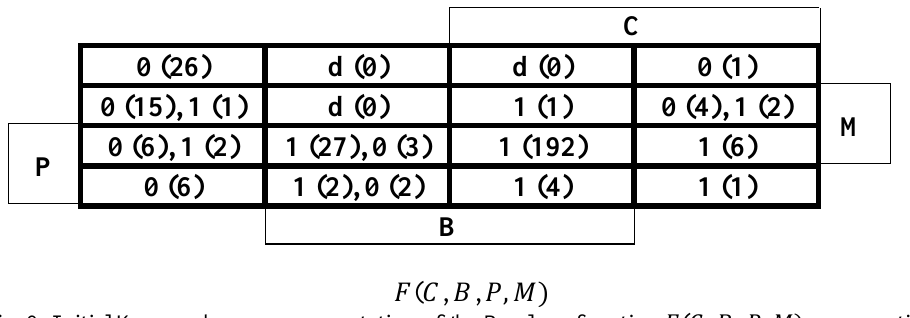
Fig. 9. Initial Karnaugh-map representation of the Boolean function 𝐹 ( 𝐶 , 𝐵 , 𝑃, 𝑀) representing an approximate gold standard with supporting cases included